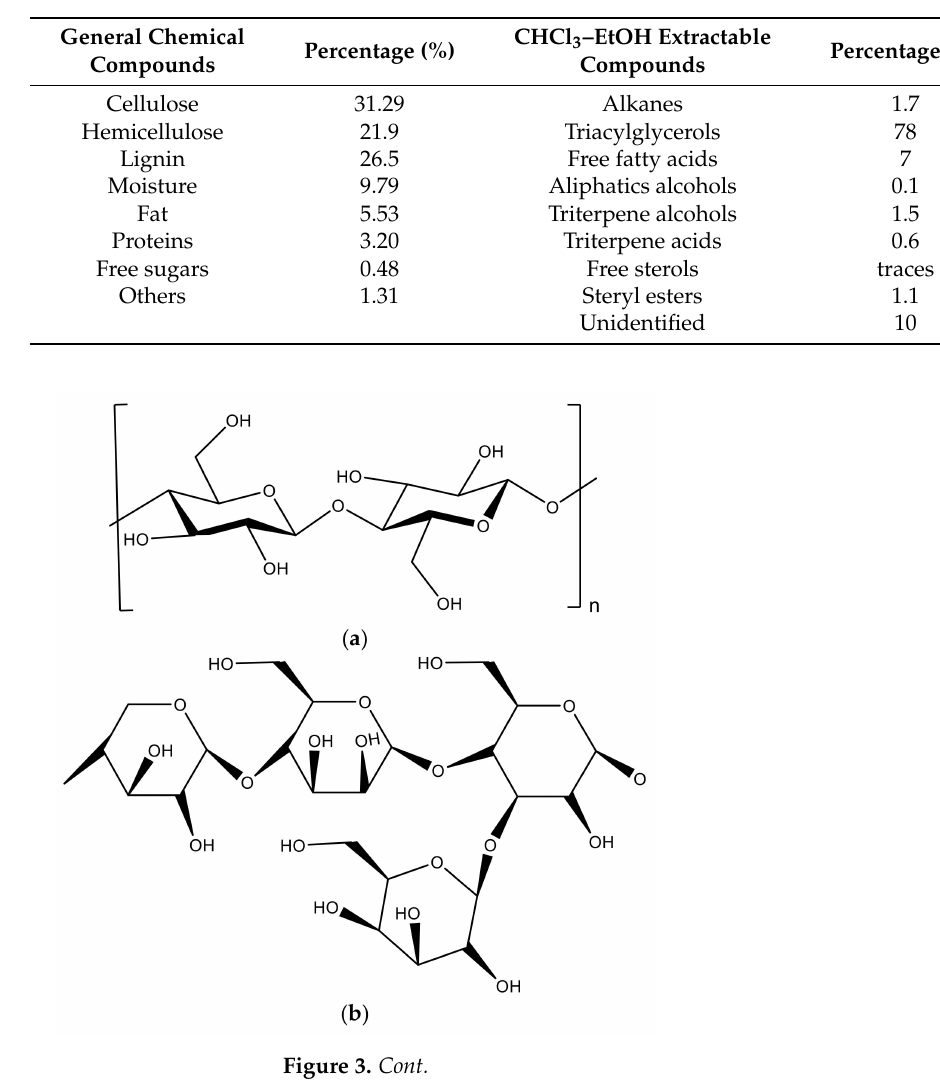
Table 2. General chemical composition (as % of dry weight), and composition (%) of CHCl 3 –EtOH extractable compounds of olive stones (adapted from [27,29]).